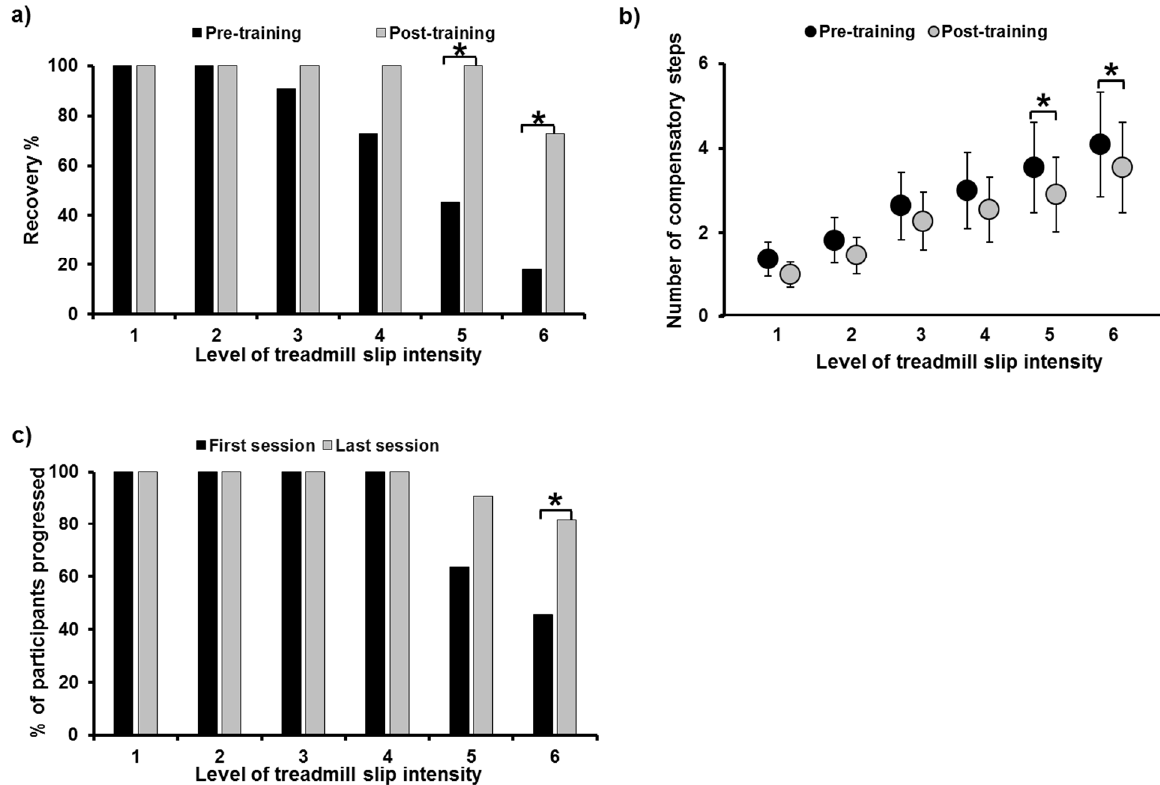
Figure 3. Figure showing ( a ) percentage of recovery and ( b ) number of compensatory steps taken post-perturbation on all six intensities of treadmill-based gait-slips (L1 to L6), comparing pre- and post-training. Figure ( c ) shows the percentage of participants who were able to progress to higher training intensities in the last training session compared to the first training session. *: Significant differences ( p ≤